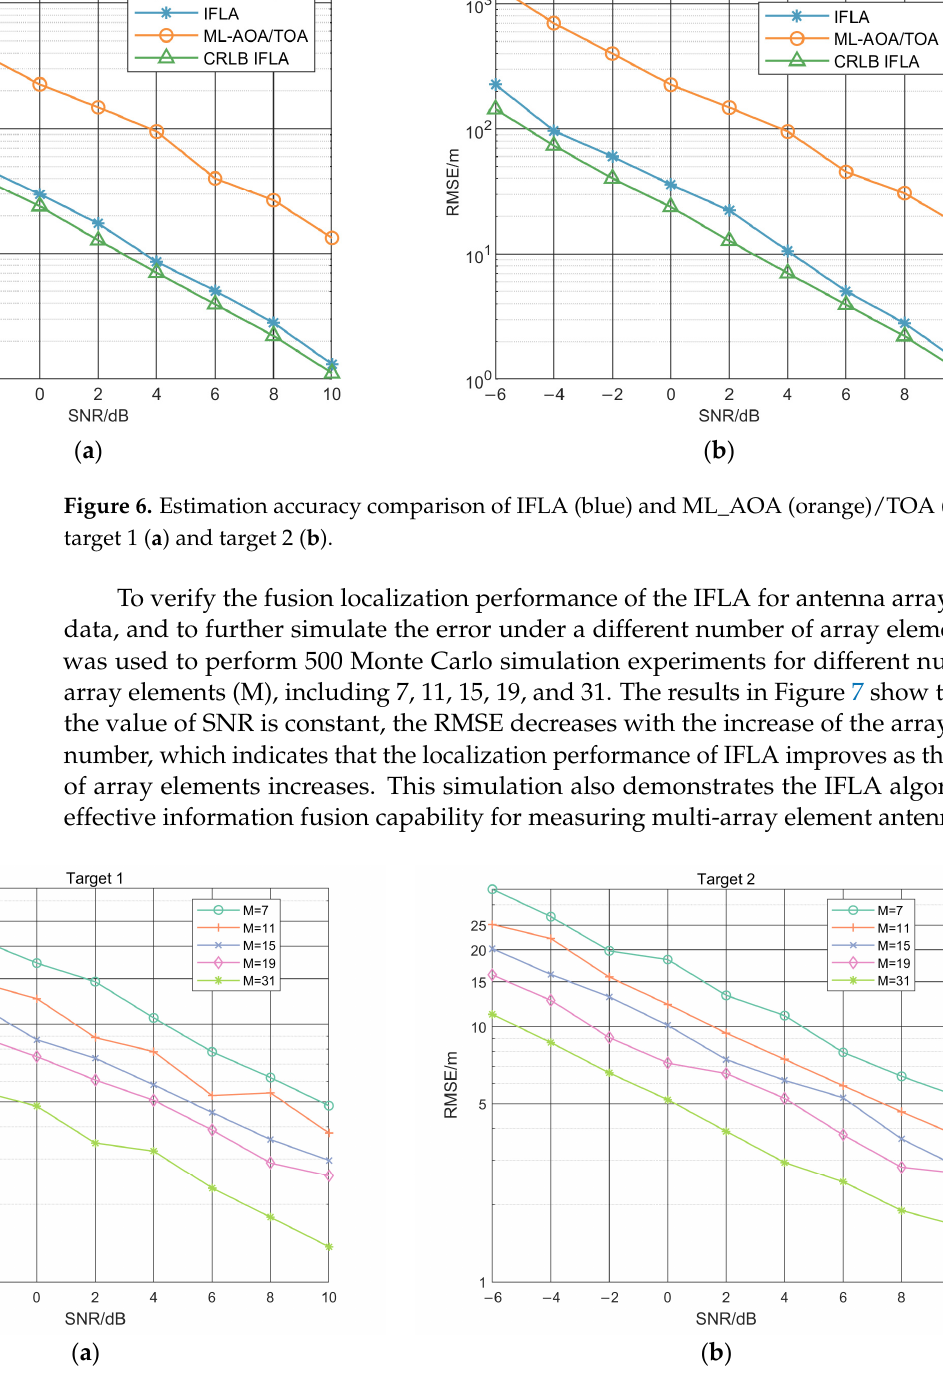
Figure 7. IFLA Localization performance comparison with di ff erent numbers of array elements (M), for target 1 ( a ) and target 2 ( b ).